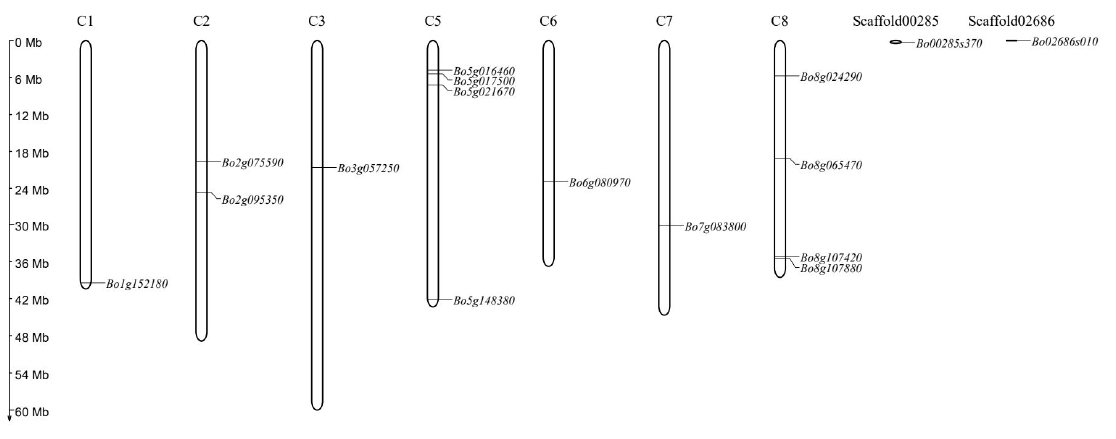
Figure 3. Chromosomal and scaffold distribution of GAPDH genes in B. oleracea .